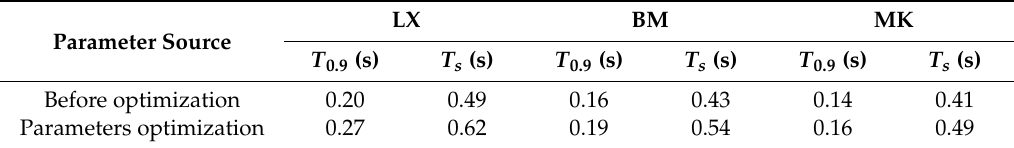
Table 3. The comparison of step response before and after optimization.